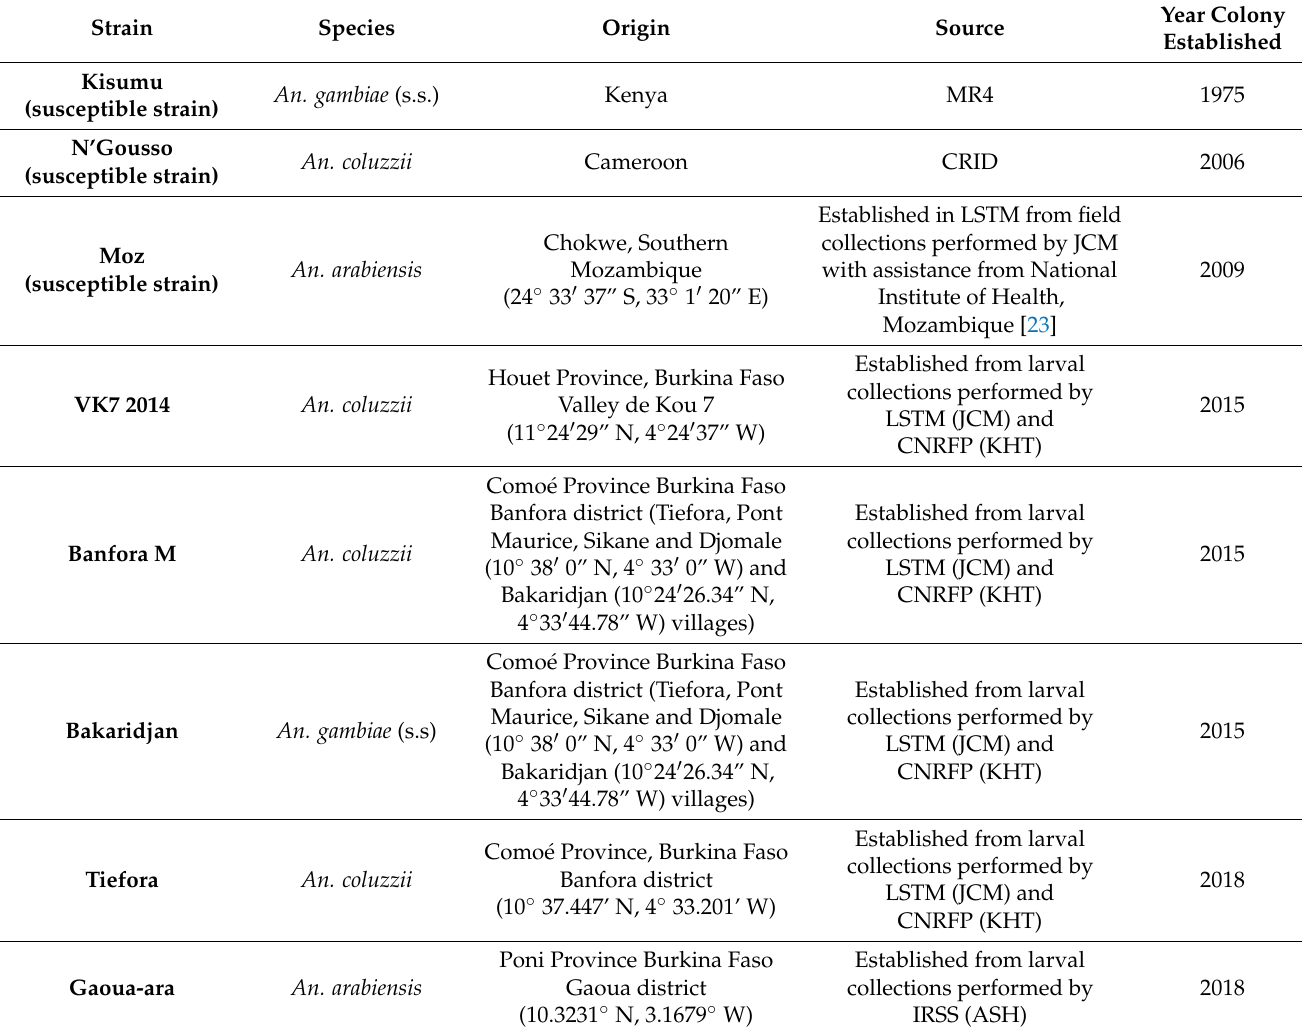
Table 1. Summary of the Anopheles gambiae s.l. mosquito strains used in the